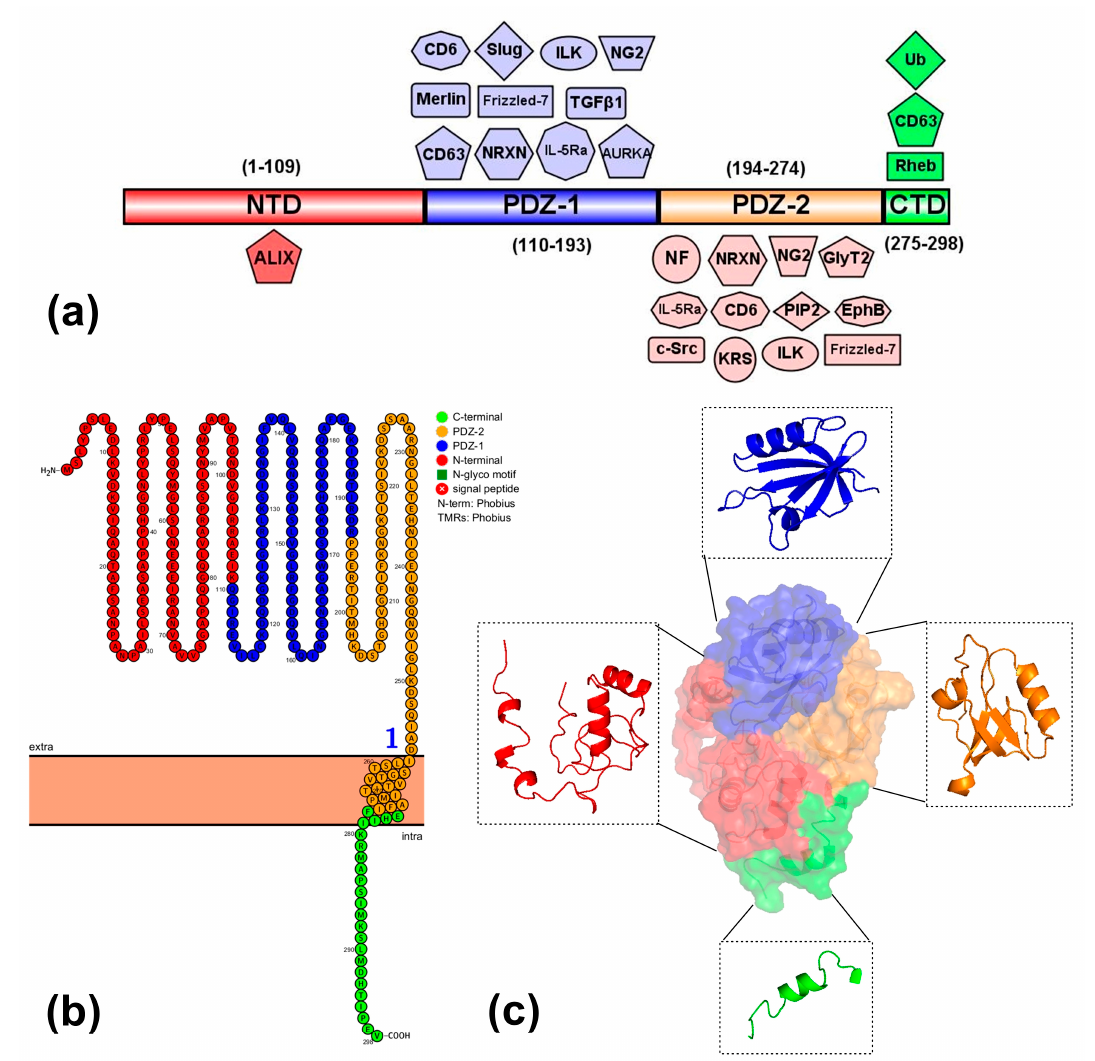
Figure 1. Structure and domains of syntenin-1. ( a ) The linear structure of syntenin-1 (access number NCBI: NP_001007068.1) shows the four structural domains and their localization (aa): N-terminal domain (NTD), PDZ1 and PDZ2 domains, and C-terminal domain (CTD). Protein and multiprotein complexes associated with each domain are also illustrated. NTD: ALIX (ALG-2-interacting protein X); PDZ1: NRXN (Neurexins), Merlin, CD6 (Cluster of differentiation 6), IL-5R α (Interleukin-5 Receptor alpha), CD63, NG2 (Neural/glial antigen 2), Fzd7 (Frizzled 7), ILK (Integrin-linked kinase), Slug, TGF β 1 (Transforming growth factor beta 1), and AURKA (Aurora Kinase A); PDZ-2: NF (Neurofascin), NRXN (Neurexins), Syndecan, GlyT2 (Glycine transporter 2), IL-5R α (Interleukin-5 Receptor alpha), c-Src (Proto-oncogene tyrosine-protein kinase Src), KRS (Lysyl-tRNA Synthetase), PIP2 (Phosphatidylinositol 4,5-bisphosphate), NG2 (Neural/glial antigen 2), Fzd7 (Frizzled 7), EphB (Ephrin B), and ILK (Integrin-linked kinase); CTD: Rheb (Ras homolog enriched in brain), CD63, and Ub (Ubiquitin). Created in IBS (Illustrator for Biological Sequences: http://ibs.biocuckoo.org/, accessed on 4 February 2023). Schematic representation of the 2D (https://wlab.ethz.ch/protter/, accessed on 5 February 2023) ( b ) and 3D structure ( c ) of syntenin-1. In red: NTD (1–109 aa); blue: PDZ1 (110–193 aa); orange: PDZ2 (194–274 aa); and green: CTD (275–298 aa). In the 2D structure ( b ), the extracellular, transmembrane, and cytoplasmic domains are shown, whereas, in the 3D structure ( c ), the surface and alpha helix/ β -sheets are illustrated. The 3D structure was obtained by ab initio structure modeling in the server RaptorX (http://raptorx6.uchicago.edu/, accessed on 5 August